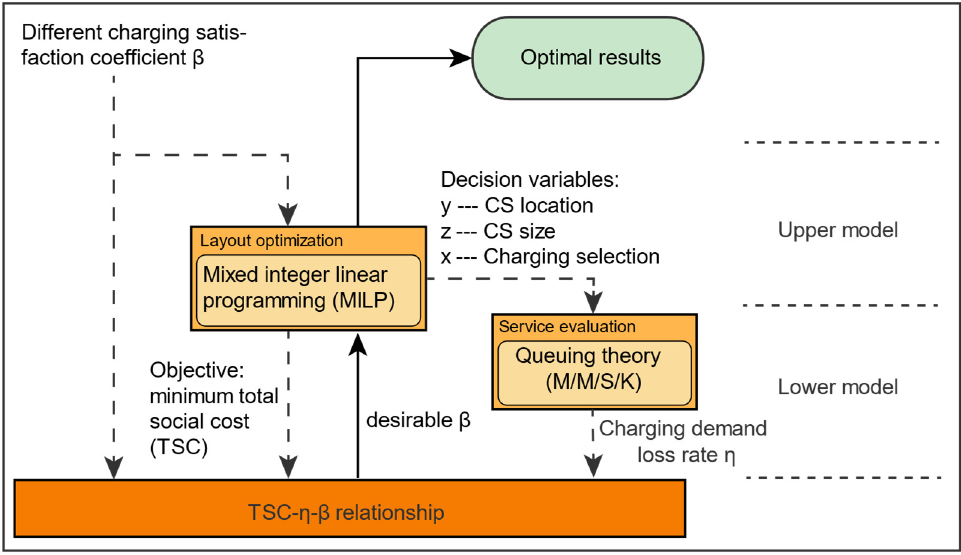
Figure 3. A two-layer layout optimization model of EV charging stations. TSC- η - β relationship can be acquired by changing the presumed parameter β in the MILP model in different loops, which can help determine the desirable value of β and corresponding optimal layout